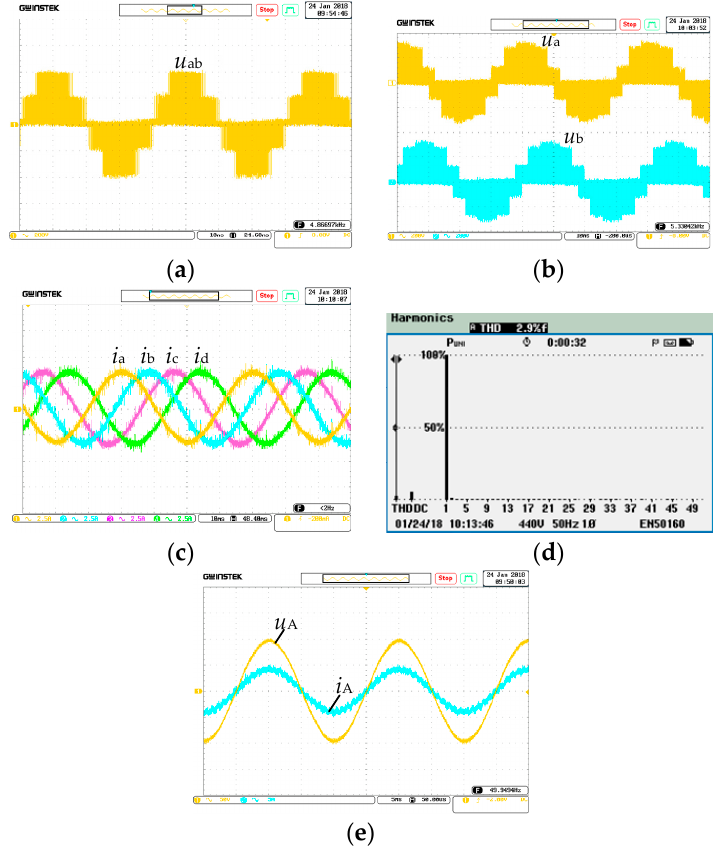
Figure 13. Experimental waveforms under the output parameter 80 V/25 Hz ( a ) output line-to-line voltage ( u ab ); ( b ) output phase voltage ( u a , u b ); ( c ) output currents ( i a , i b , i c , i d ); ( d ) the FFT analysis of i a ; ( e ) input phase voltage and current ( u A , i A ).